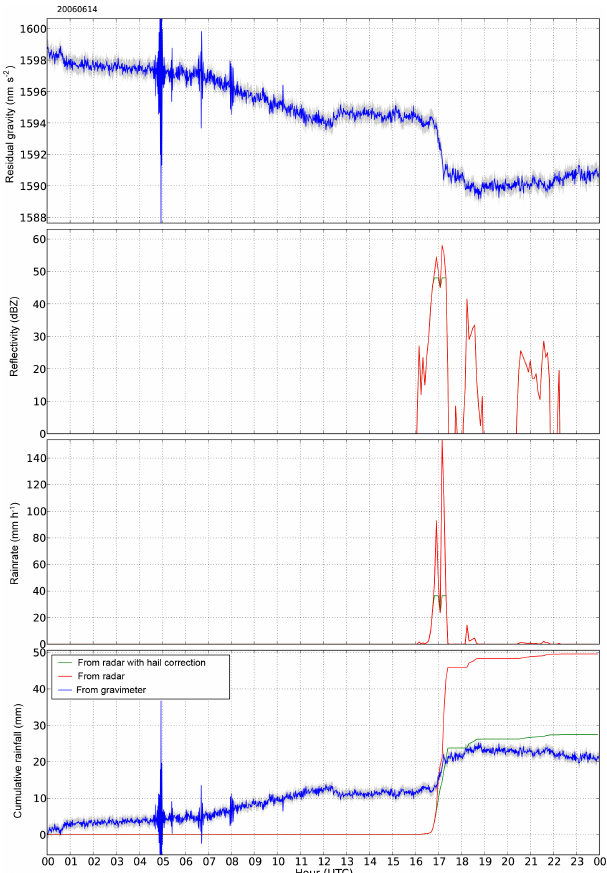
Figure 8. Residual gravity, radar reflectivity, radar rainfall rate and cumulative rainfall time series for 14 June 2006, not corrected for hail (red) and corrected with a hail threshold of 48dBZ